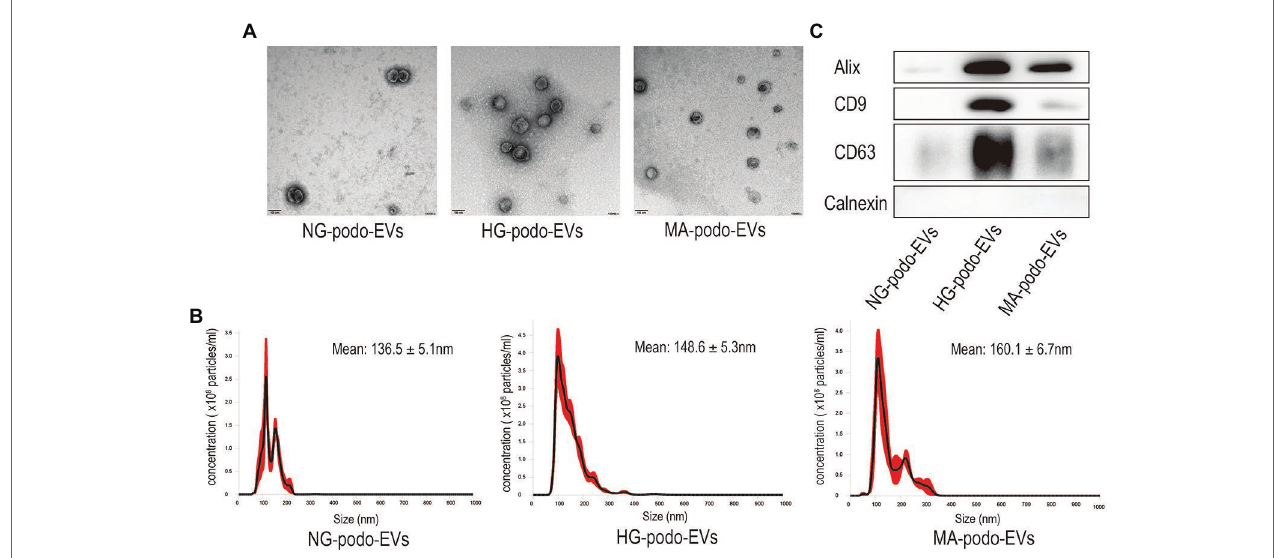
FIGURE 1 | Characterization of EVs isolated from podocytes after NG, MA, and HG treatment. (A) EVs were observed by TEM. Magnification, ×100,000. Scale bar, 100 nm. (B) The size distribution of EVs was determined by NTA. (C) Western blot analysis of Alix, CD9, and CD63, and the EV negative marker Calnexin.